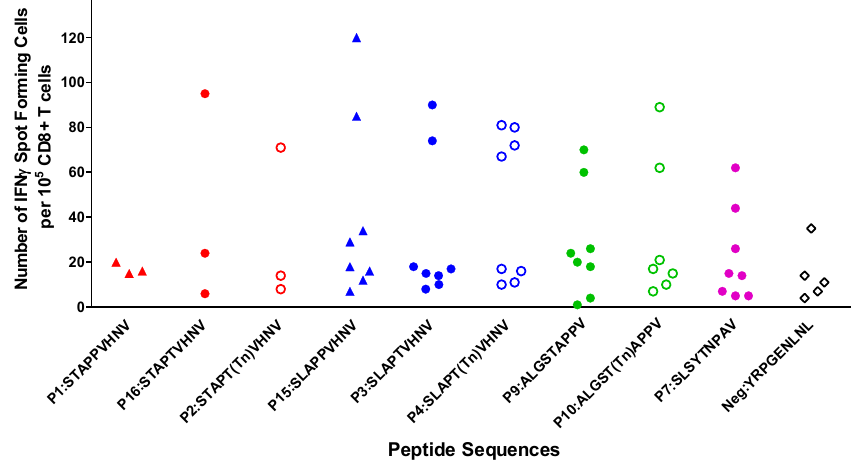
Figure 5. Production of IFN γ by CD8 + T cells was induced in response to MUC1 peptides. Following two rounds of stimulation, CD8 + cells were maintained for 24 h on an ELISpot plate. Spot numbers were determined using computer assisted video image analysis by Zellnet Consulting Inc. There were no significance differences compared to the negative peptide ( p > 0.05). 2.5. Breast Cancer Patients Recognize and Proliferate to the MUC1 Peptides in Vitro To determine if breast cancer patients have T cell repertoires that recognize these MUC1 peptides, we screened 23 HLA ‐ A*0201 breast cancer patients regardless of their stage, ER/PR and HER2 status with four selected peptides (P1, P3, P4, P15). CD8 + T cells from the patients were incubated with irradiated autologous DCs pulsed with the various MUC1 peptides (10 μ g/mL) plus IL ‐ 2 for 5 days and proliferation was assessed by measuring the 3 H ‐ thymidine uptake. T cells from ~38% of the breast cancer patients responded to the selected MUC1 peptides (Figure 6). Figure 6. T cells from ~38% of the HLA ‐ A2 + breast cancer patients regardless of their stage, ER/PR and HER2 status responded to the selected MUC1 peptides. 1 × 10 5 T cells were incubated with irradiated allogeneic DCs pulsed with the various MUC1 peptides (10 μ g/mL) + IL ‐ 2 for 5 days in complete media. Proliferation was assessed by measuring the 3 H ‐ thymidine uptake and is reported as fold increase in counts per minute. The dotted line indicates the two ‐ fold increase in proliferation.